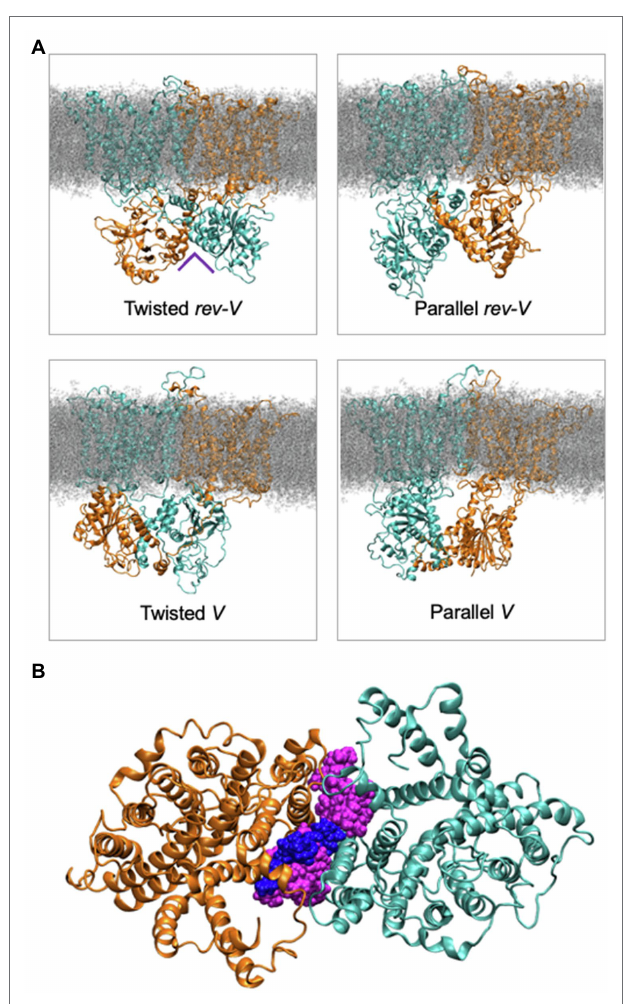
FIGURE 5 | (A) Molecular dynamics simulation snapshots showing the four different models in the relative orientation of the cytoplasmic domain in the intact Band 3 in a complex lipid bilayer. One of Band 3 monomers is shown in orange and the other in cyan. Lipids are shown in grey. The Twisted models (left) indicate a domain swap of the membrane and cytoplasmic domains. (B) Cytoplasmic view of a simulation with the intact Band 3 highlighting the lipids at the dimer interface during the simulations. The cytosolic region of Band 3 and the rest of the bilayer are omitted for clarity (Adapted from de Vecchis et al.,